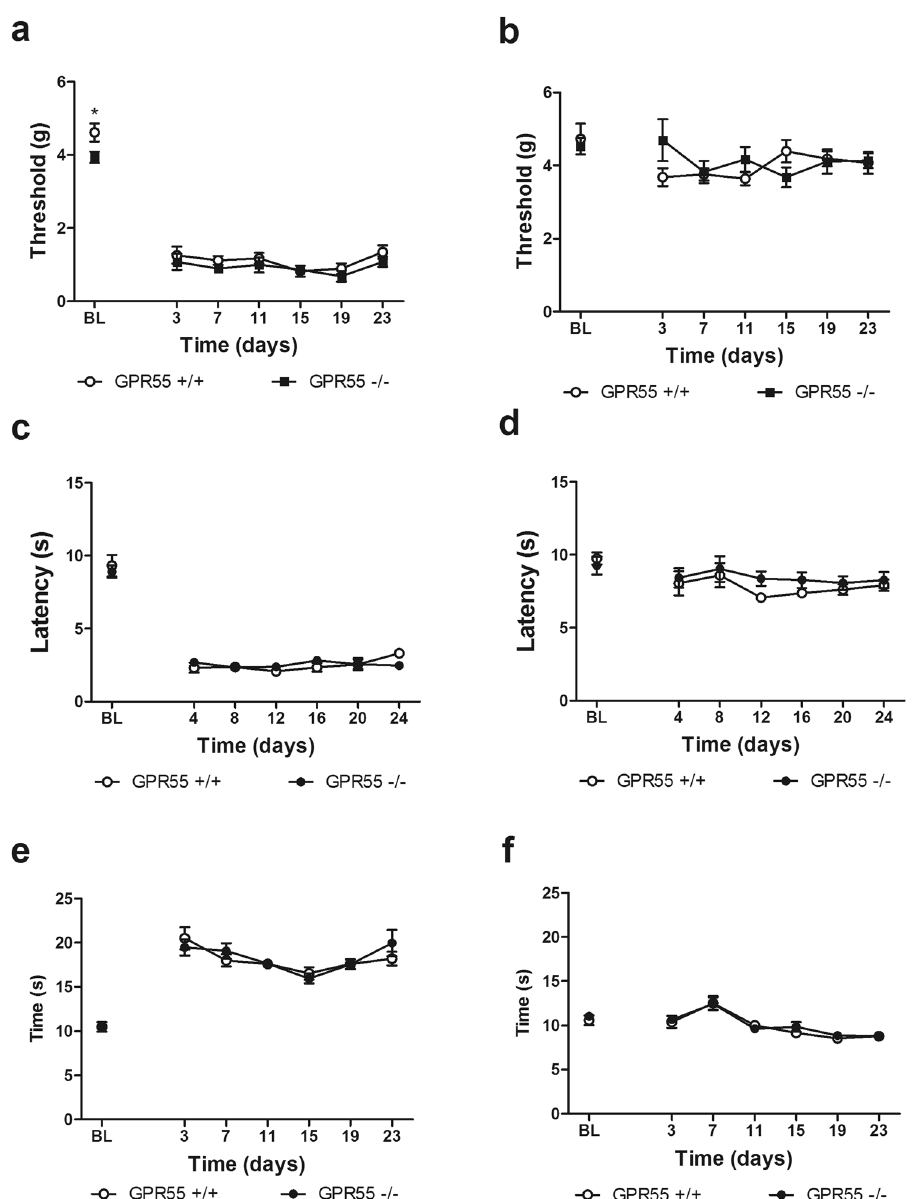
Figure 7. GPR55 KO and WT mice develop similar levels of hypersensitivity to mechanical, heat, and cold stimulation following a partial sciatic nerve ligation. GPR55 KO and WT mice develop similar levels of mechanical ( a ), heat ( c ) and cold allodynia ( e ) in the paw ipsilateral to PSNL. Responses of the contralateral paw to mechanical ( b ), heat ( d ) and cold ( f ) stimulation did not differ between genotypes. Data are expressed as mean ± SEM (n = 7–8 per group). 2-way ANOVA. 2-tailed t-test. * p < 0.05 vs. GPR55